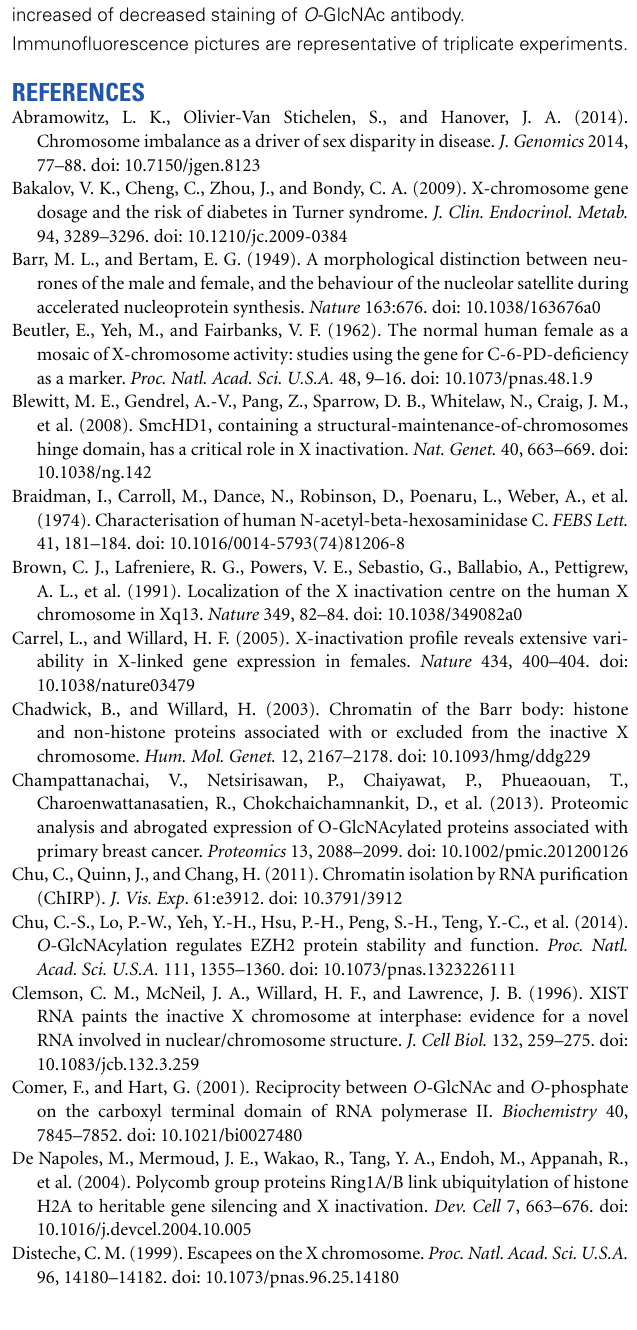
Figure S1 | Barr bodies exclude O -GlcNAcylated proteins and elongating RNA polymerase II (phospho S2/5). (A) RNA-FISH specificity is confirmed by positive and negative control sets, using PPIB/ RNA pol II mRNA and Bacterial mRNA probes, respectively. (B) An additional elongating RNA polymerase II (phospho S2/5) antibody confirms the exclusion of O -GlcNAcylation from Barr Bodies. (C) Fluorescent secondary antibodies alone show the specificity of primary antibodies used in this study. (D) Efficiency of Thiamet G and azaserine is demonstrated respectively by increased of decreased staining of O -GlcNAc